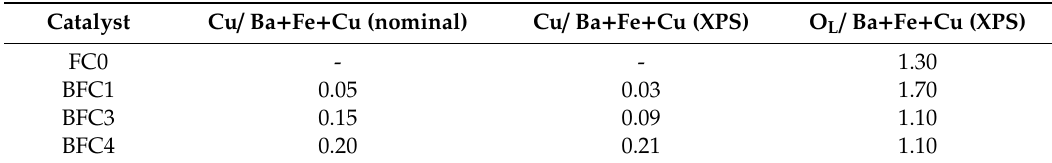
Figure 3. XPS spectra for Cu2p 3 / 2 transition. Table 3. XPS characterization data of BaFe 1 − x Cu x O 3 catalysts.